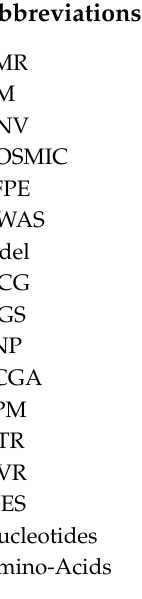
Table S1: Total somatic mutations for all the samples; Table S2: Recurrent mutations based on COSMIC; Table S3: Biological processes from GO (MAPK pathway and Cell cycle), with the corresponding mutated genes in each patient; Figure S1: Top Census genes in melanoma from COSMIC database and the type of mutation found in all